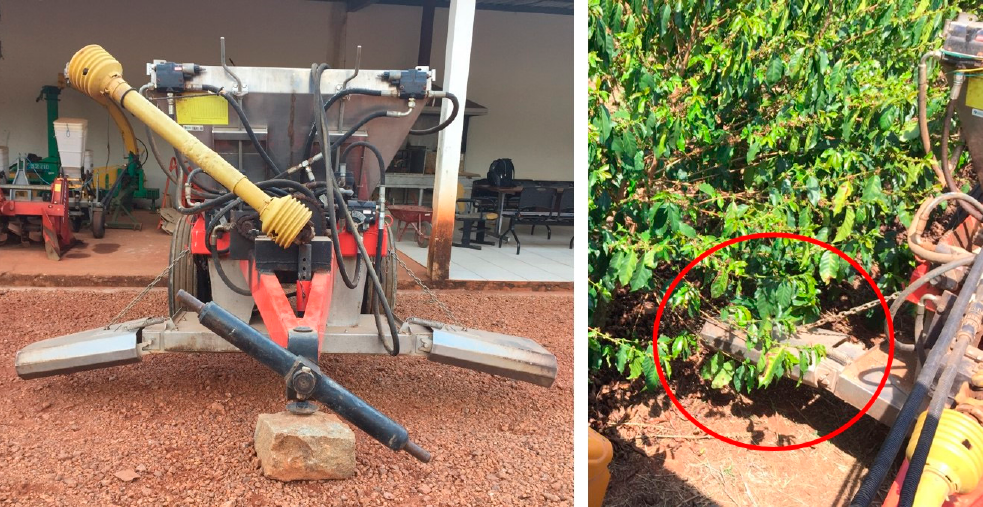
Figure 2. Agronomy 2020 , 10 , x FOR PEER REVIEW